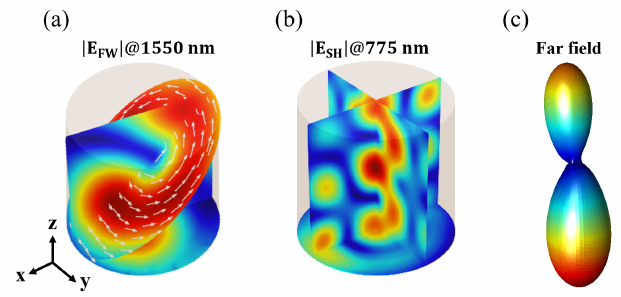
Figure 3. Near-field distributions of electric field magnitude at the fundamental wavelength ( a ) and harmonic wavelength ( b ), respectively. ( c ) gives the second-harmonic radiation